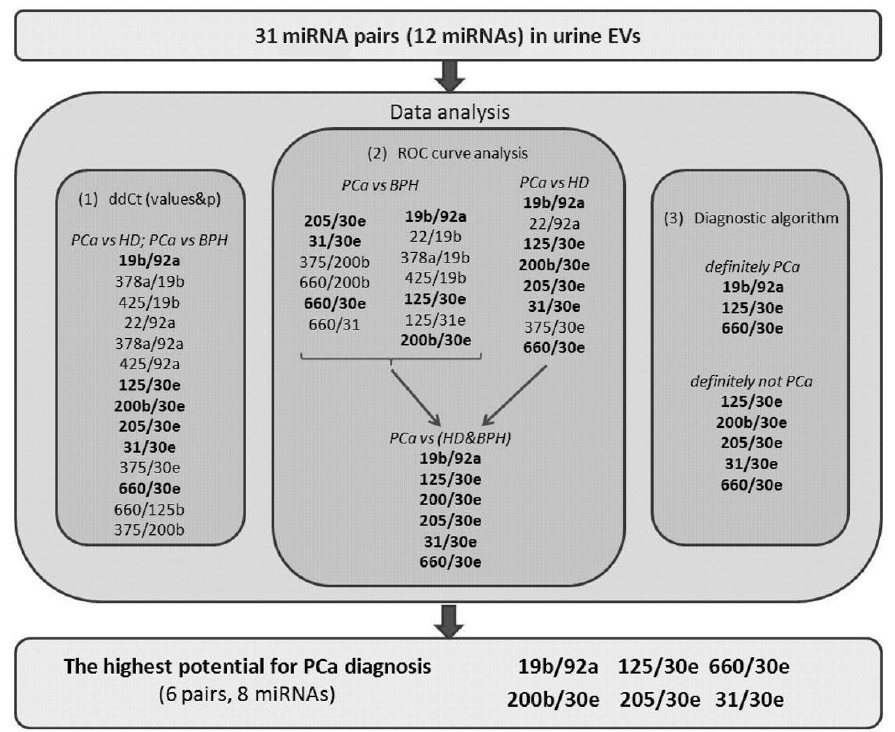
Figure 2. The course of the